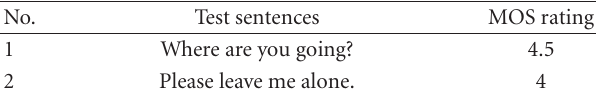
Table 3: Sample MOS for sentences.